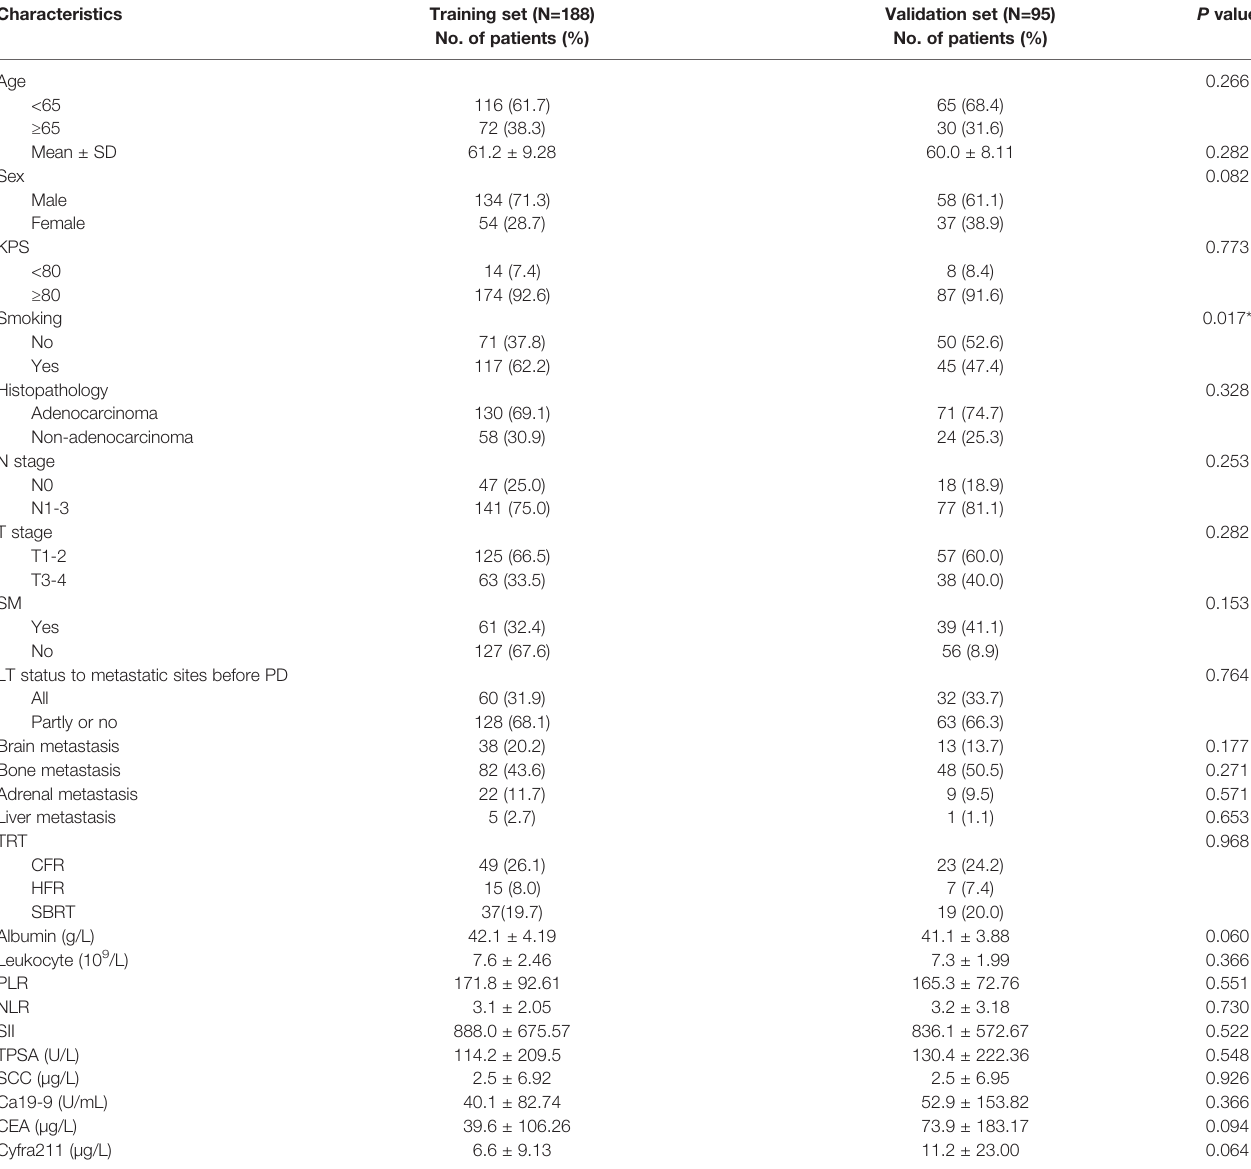
TABLE 1 | Clinical characteristics of